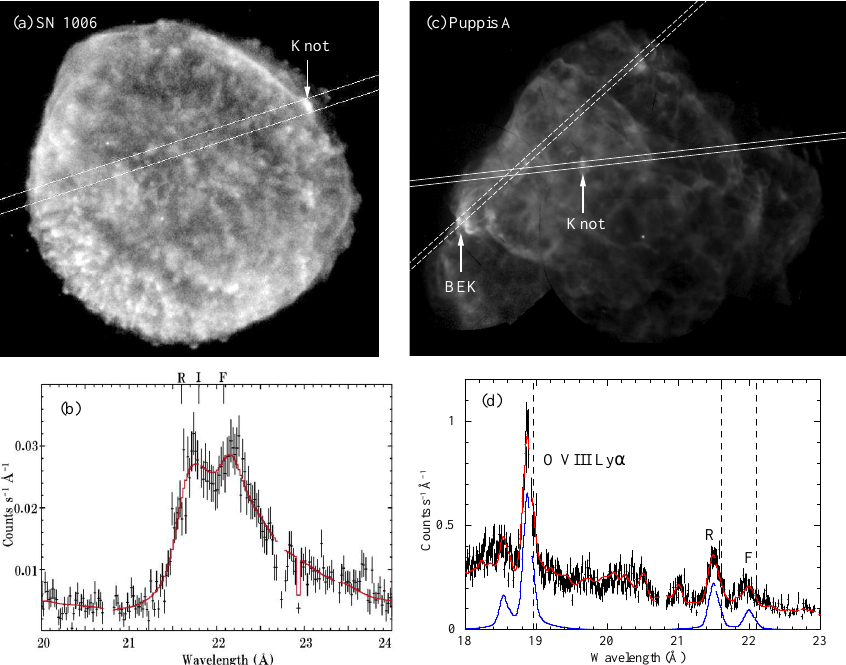
Figure 1: (a) X-ray view of SN 1006 in 500–599 eV, taken from Broersen et al. (2013). The RGS field of view is within the two lines. (b) RGS spectra zooming into O VII He α from the NW knot in SN 1006. The positions of the resonance (21.6˚A), the intercombination (21.8˚A), and the forbidden line (22.1˚A) are indicated. This figure is taken from Broersen et al. (2013). (c) X-ray view of the Puppis A SNR in 0.5–5 keV. The RGS spectra taken from the two solid lines (hosting the knot) or dashed lines (hosting the BEK) are shown in Fig. 1 (d) and Fig. 3, respectively. (d) RGS spectrum zooming into O K-shell lines from the ejecta knot in Puppis A. In the model, the contribution from the knot is indicated as a blue line. Rest-frame positions of the O VIII Ly α (18.9˚A) and the O VII He α lines are indicated as dashed lines. The blueshifts are clearly